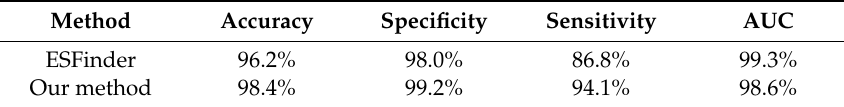
Table 4. Performance comparison between ESFinder and our method.